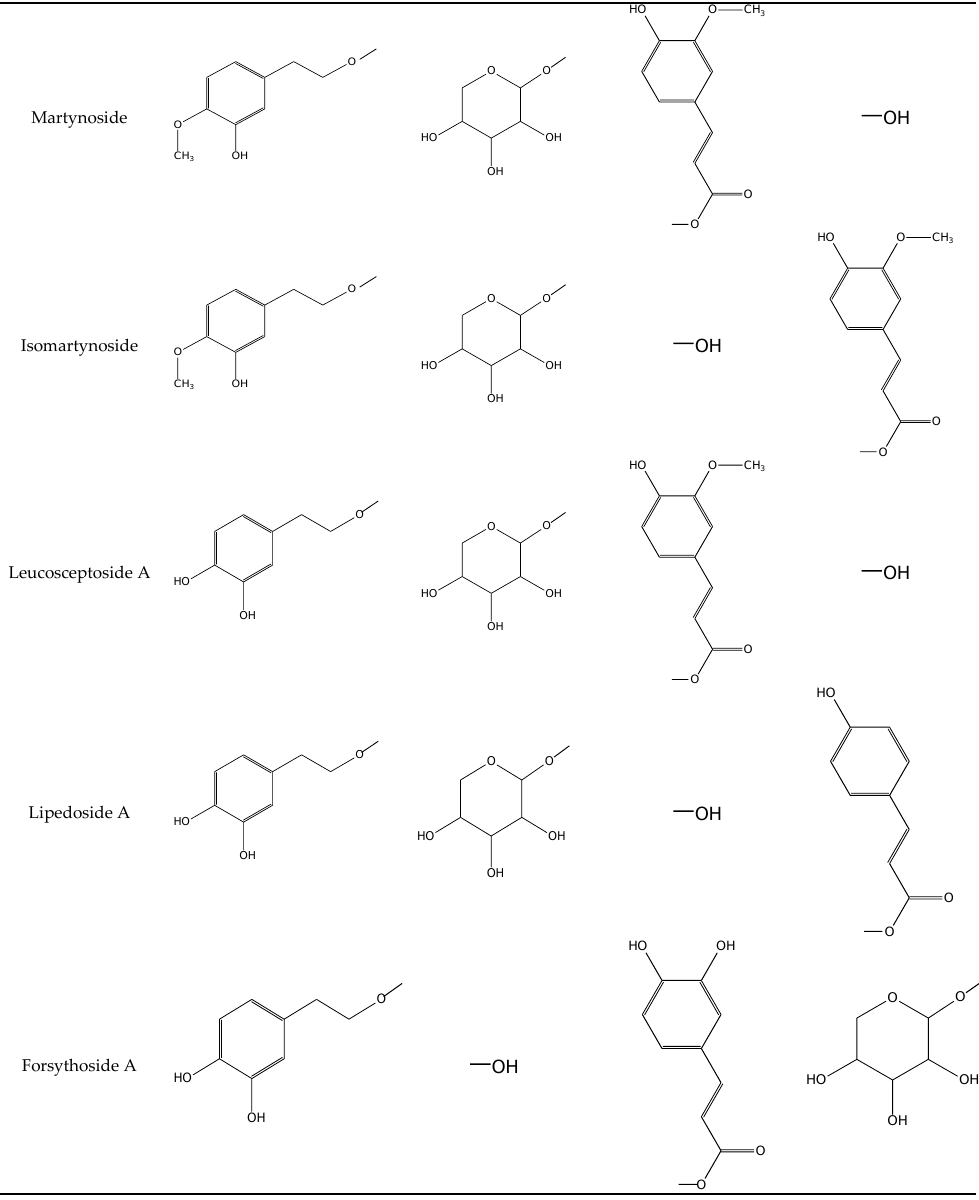
Figure 2. Chemical structures of phenylethanoids in aerial parts of S. viridis.